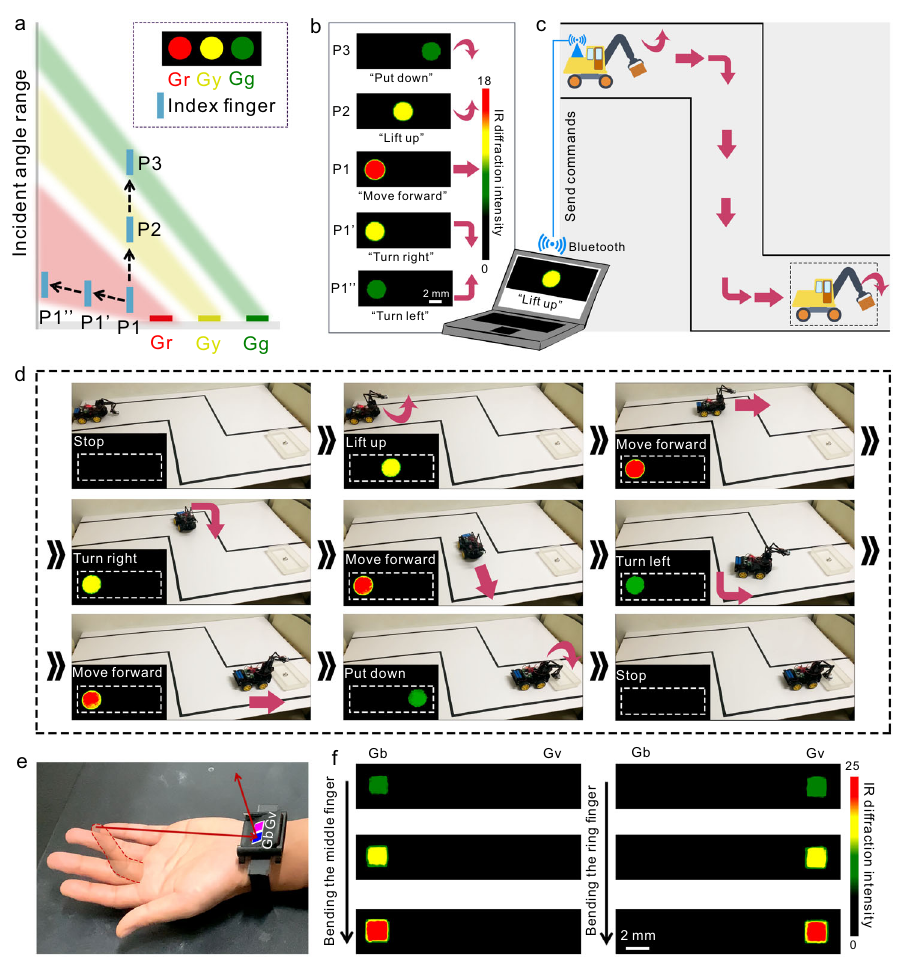
Fig. 4 Demonstration of real-time HMI based on fi nger-responsive IR structural colors. a Schematic of the positions of the fi nger for the generation of multiplexed IR structural colors. b Generated patterns of IR structural colors and the corresponding recognized commands. The commands are recognized based on the combination of both IR structural colors and the positions of colors. c Schematic illustration of the task of the robot vehicle in the proof-of- concept demonstration. The commands are sent to the Bluetooth on the robot vehicle to perform different actions. d Real-time actions of the robot vehicle based on the fi nger-responsive IR structural colors. e Two gratings (blue grating (Gb) and violet grating (Gv)) are integrated into a wrist band, which are aligned with the middle fi nger and the ring fi nger respectively. f The generated IR color patterns with the bending of the middle fi nger/ring fi